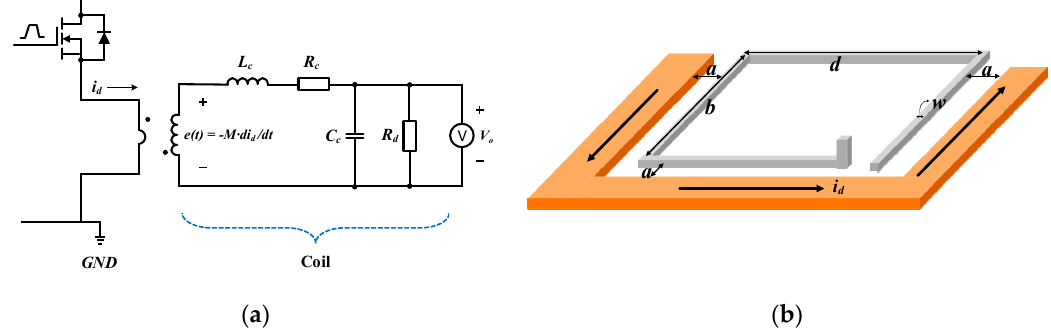
Figure 6. PCB circuit analysis using finite element method: ( a ) current flow of 5 ×10 0 A; ( b ) top view of magnetic flux density; ( c ) side view of magnetic flux density.